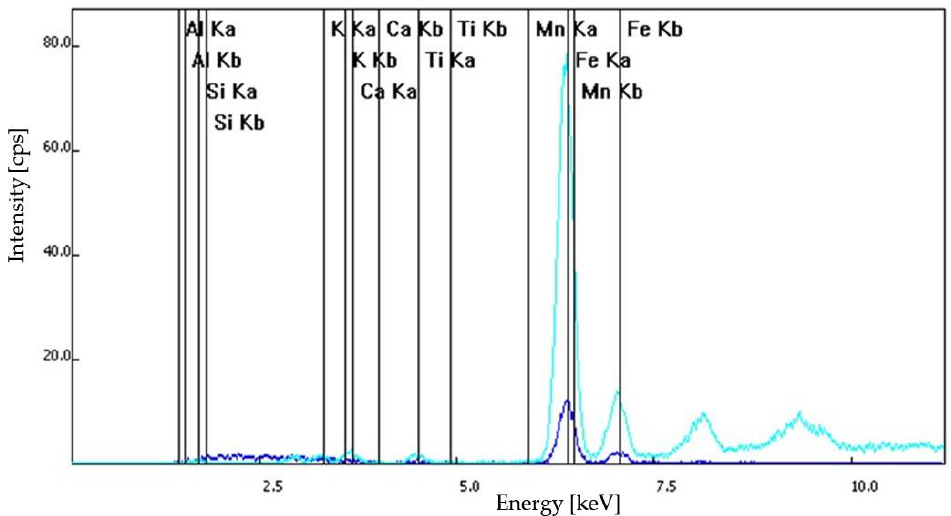
Figure 11. S4 sample series: XRF spectra. The primary and secondary minerals found in the composition of the samples were highlighted by a microscopic examination (Figure 12). The dimensions of the primary components of the S1 sample, dislodged from the original wall of Frumoasa monastery, are listed in Table 3.